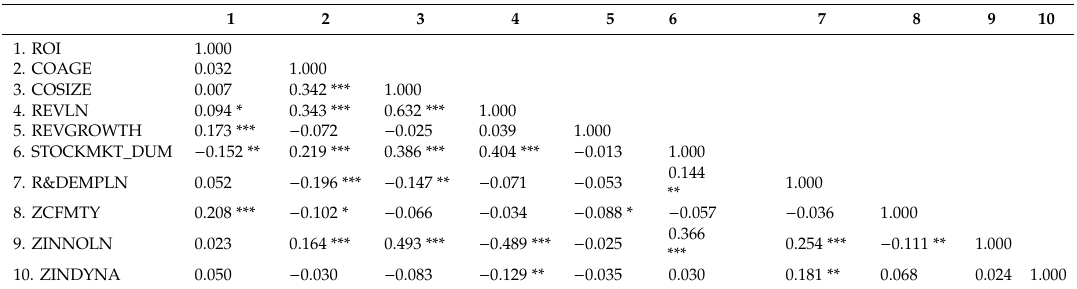
Table 1. Descriptive statistics and correlation matrix (N = 448).